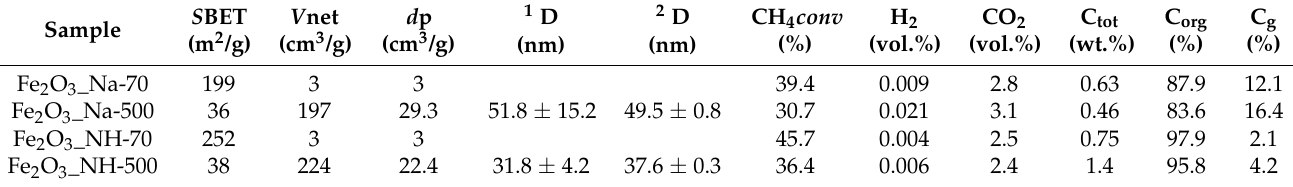
Table 1. Surface area S BET , net pore volume V net , pore size d p and the mean crystallite size D of samples calcined at 500 ◦ C; Catalytic methane conversion (CH 4 conv ) after 2 h to CO 2 and